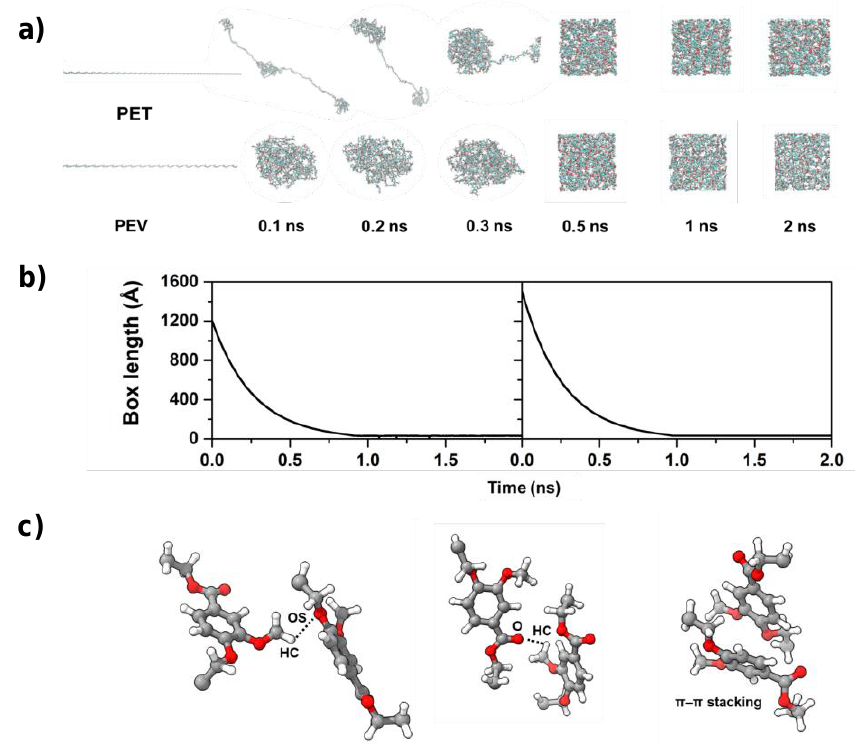
Figure 3. ( a ) The folding conformations of single-chain polymers PET and PEV upon simulation time at 600 K and 250 atm, where the plot of box lengths is shown in ( b ); ( c ) the possible hydrogen bonds formed between the methoxy group on the aromatic ring of a PEV unit and the ether and carbonyl oxygens of the neighboring units. Parallel-displaced π–π stacking between the aromatic rings is also presented.